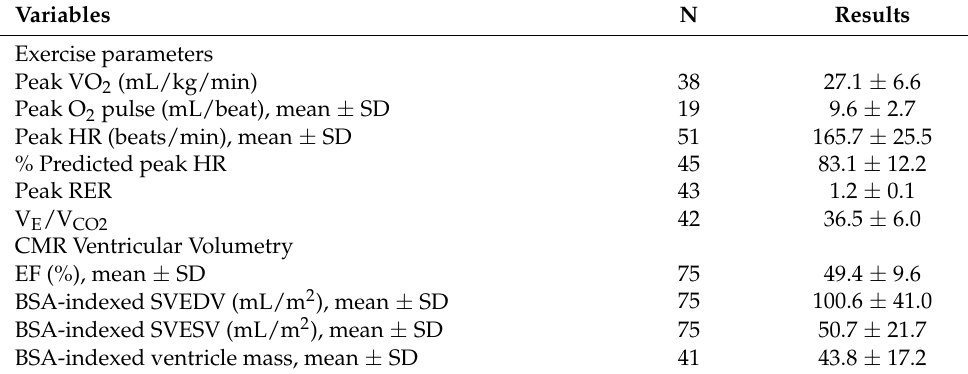
Table 2. General exercise and CMR